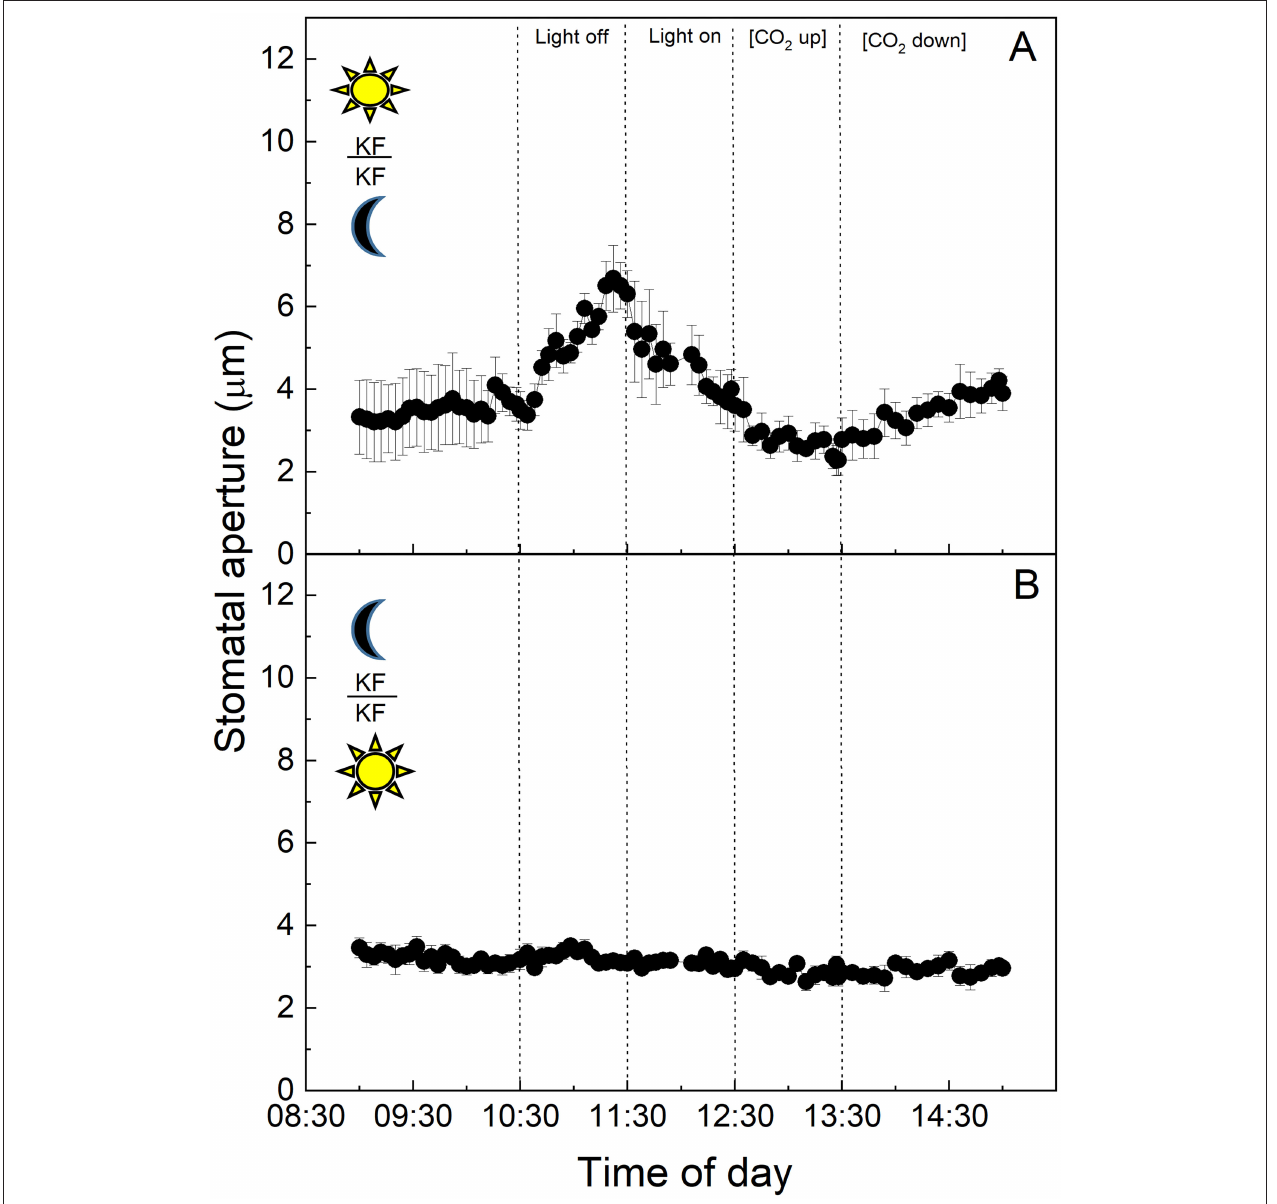
FIGURE 7 | (A) Abaxial peeled epidermis of Kalanchoë fedschenkoi leaf from the “light” growth chamber, on abaxial exposed mesophyll of Kalanchoë fedschenkoi leaf, from the “dark” growth chamber; (B) Abaxial peeled epidermis of Kalanchoë fedschenkoi leaf from the “dark” growth chamber, on abaxial exposed mesophyll of Kalanchoë fedschenkoi leaf from the “light” growth chamber (light period 8:00a.m. to 8:00 p.m.), and from the “dark” growth chamber (reverse light period 8:00 p.m. to 8:00a.m.). Light intensity was changed from photon flux density of 400 ± 1 0 µ mol m − 2 s − 1 to darkness, as indicated, and [CO 2 ] was changed from 120 to 650 µ mol mol − 1 , as indicated. The temperature of the chamber was maintained at 23 ± 1 ◦ C. The values are means of four repetitions ( ± SE). The sun symbol represents plants taken from the light-grown chamber and the moon symbol represents plants taken from the dark-grown chamber. in the guard cell pairs of CAM leaves of K. fedtschenkoi